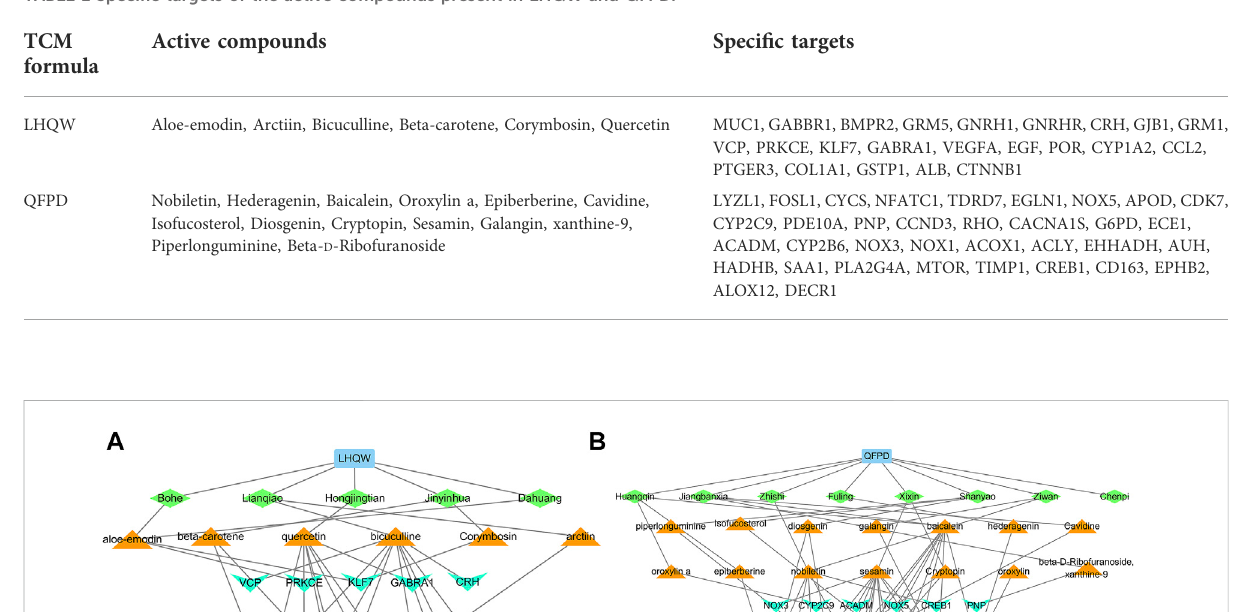
TABLE 1 Speci fi c targets of the active compounds present in LHQW and QFPD.